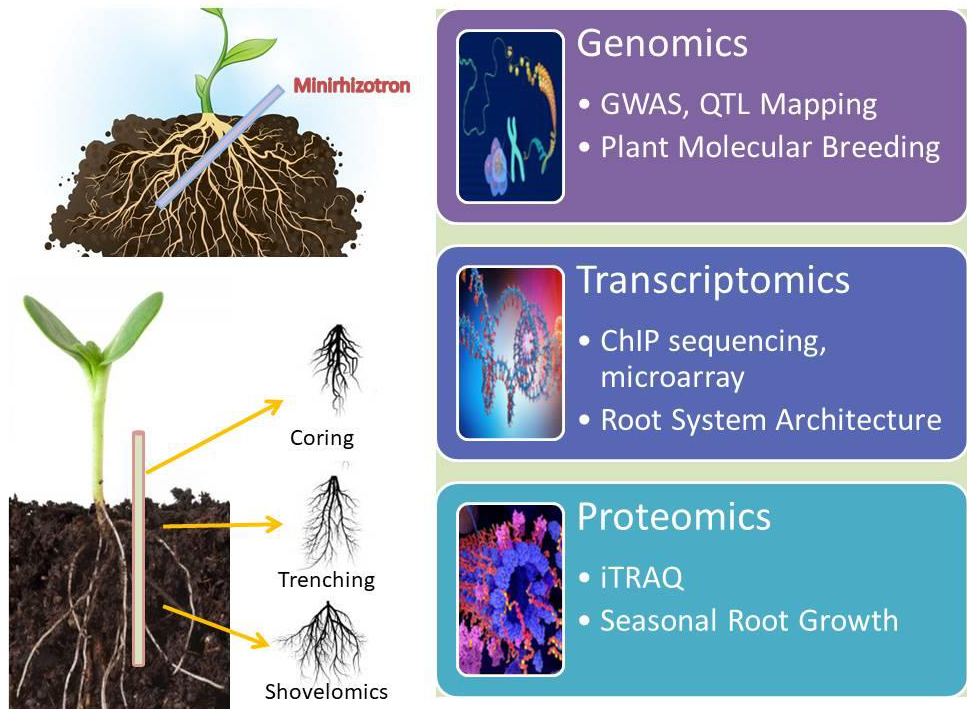
Figure 2. Overview of the plant root phenotyping and genomics tools to measure root system architecture. Root phenomics (left) include invasive sampling techniques, such as coring, trenching, and shovelomics, and non-destructive sampling techniques, such as minirhizotron. To analyse the effect of various abiotic stresses on root system architecture, different genomics tools, such as GWAS, QTL mapping, RILs, transcriptomics, and proteomics, such as iTRAQ, are used (right).